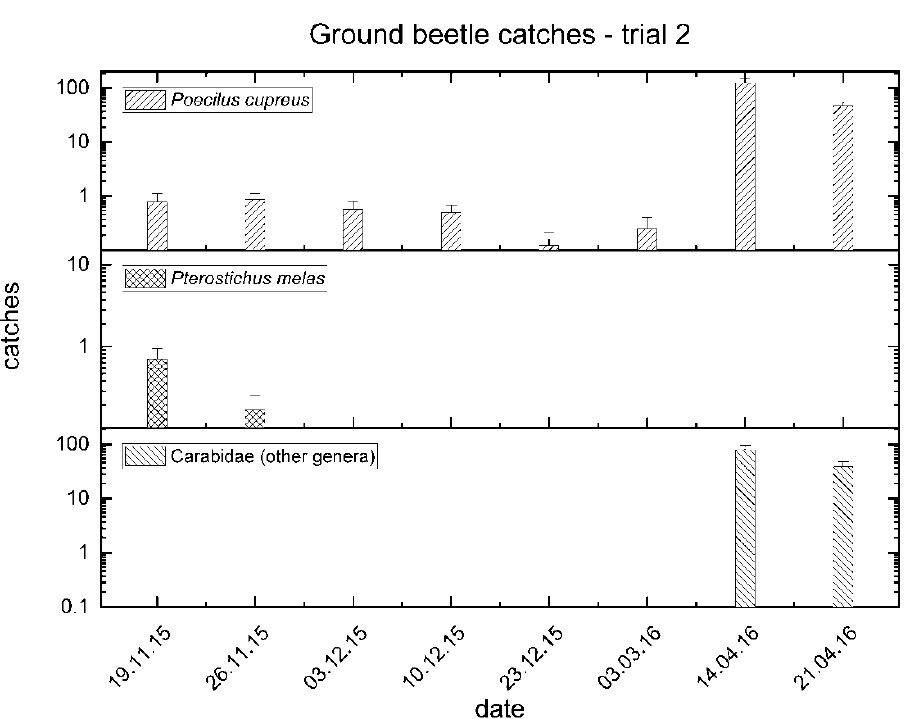
Figure 4. Mean catches of ground beetles between November 2015 and June 2016 in trial no. 2.